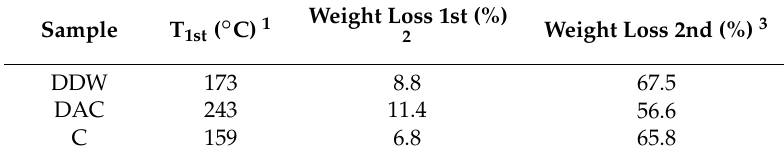
Figure 4. Thermal gravimetric analysis (TGA) and differential scanning calorimetry (DSC) curves of collagens. ( a ) TGA curves indicate the weight loss evolution of collagen with increasing temperature. ( b ) DSC curves represent the heat flow evolution of collagen with increasing temperature. Table 2. Thermal gravimetric data for collagens.